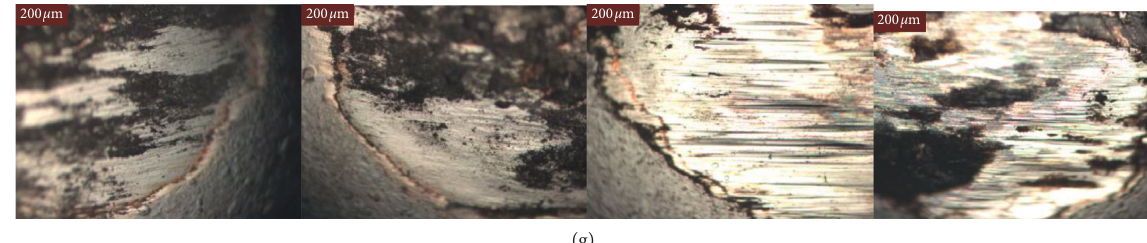
Figure 15: Optical micrographs of the composite samples and counter-body. (a) Base composition. (b) Composition 1. (c) Composition 2. (d) Composition 3. (e) Composition 4. (f) Composition 5. (g)